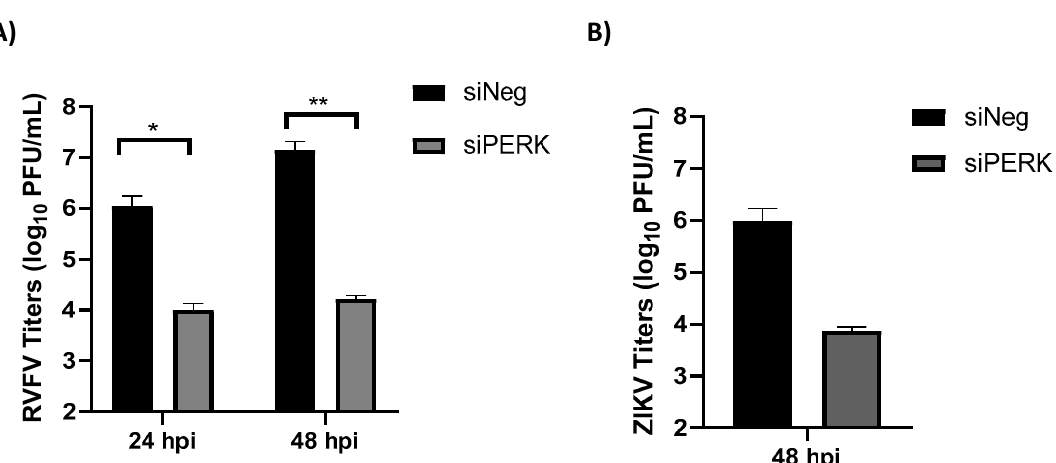
Figure 7. Loss of PERK results in the reduction of Rift Valley fever virus (RVFV) and Zika virus (ZIKV) infectious titers. Primary human astrocytes were transfected with 100 nM of siNeg or siPERK siRNAs. At 48 h post transfection, cells were infected with ( A ) RVFV MP12 (MOI 5) or ( B ) ZIKV MR776 (MOI 5). Viral supernatants were collected at the indicated time points and viral titers determined via plaque assay. Data are expressed as the mean ± SD ( n = 3). * p ≤ 0.5, ** p ≤ 0.02.